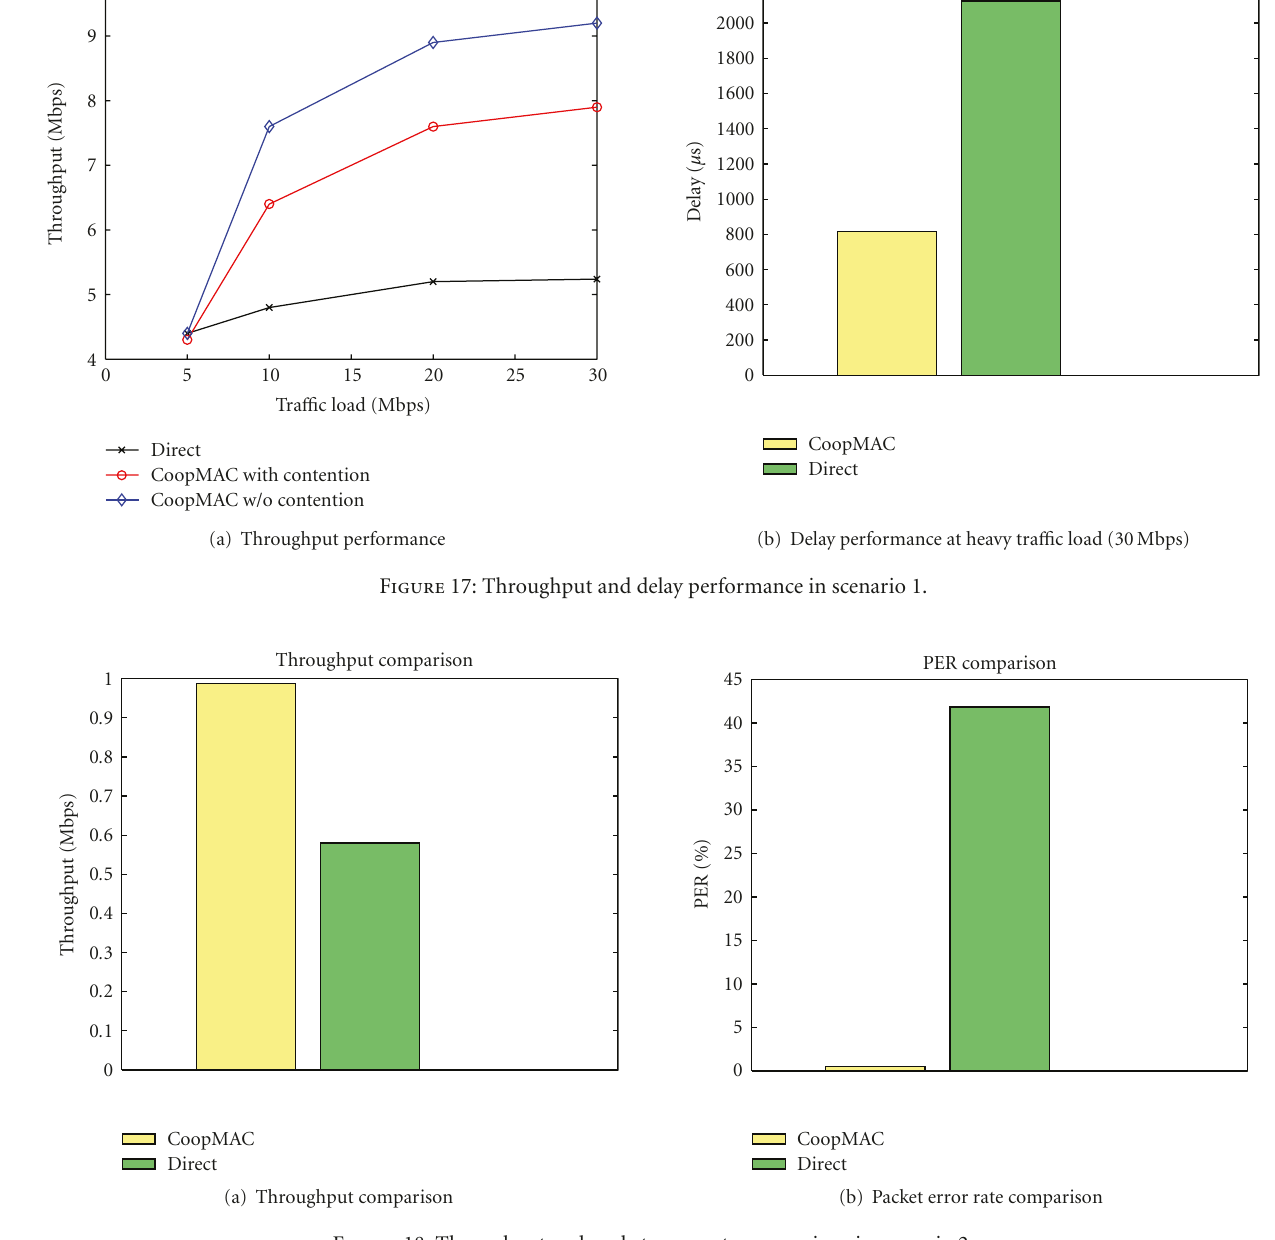
Figure 18: Throughput and packet error rate comparison in scenario